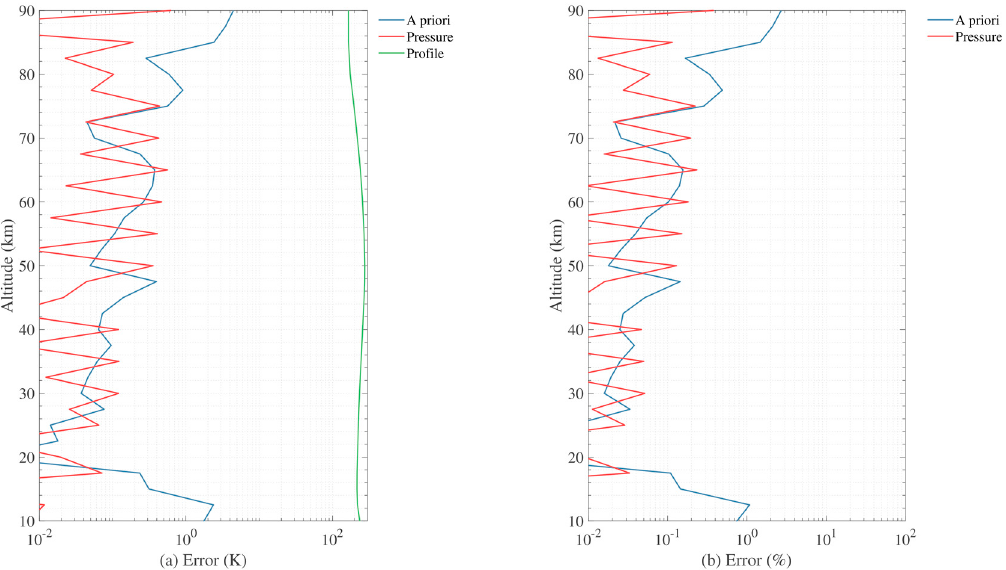
Figure 8. The temperature retrieval errors induced by external error sources: ( a ) absolute and ( b ) relative retrieval errors. The uncertainties assumed are summarized in Table 5.